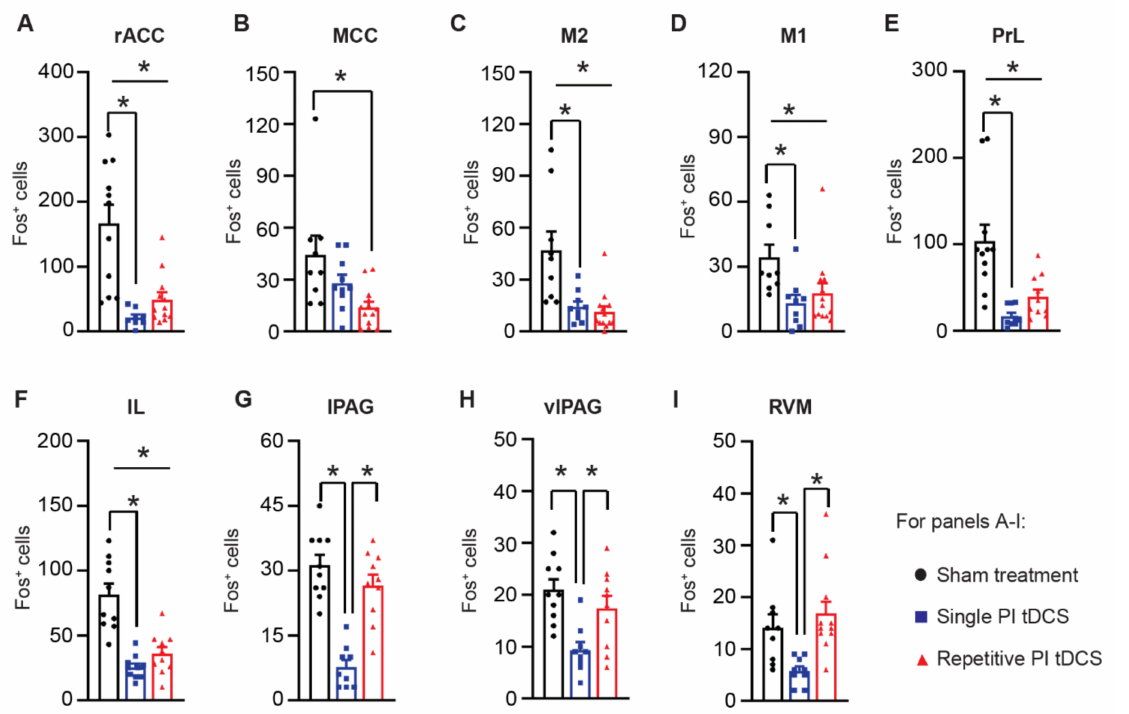
Figure 6. Immunohistochemical analysis of the surrogate marker for neuronal activity, Fos, in diverse brain regions following tDCS stimulation of PI in the form of either a single PI tDCS session or repetitive stimulation over five consecutive days compared to sham treatment. ( A – I ) Quantitative analysis of a number of Fos-expressing cells per region of interest. n = 9 sections from three mice in the sham treatment group, n = 10 sections from four mice in the single PI tDCS group, and n = 16 sections from four mice in the repetitive PI tDCS group; repeated ANOVA with Sidak’s multiple comparisons tests were performed; * p < 0.05 as compared to the corresponding control group. n.s.: non-significant. Data are represented as mean ± S.E.M. Abbreviations: rostral anterior cingulate cortex (rACC), midcingulate cortex (MCC), primary and secondary motor cortex (M1 and M2), prelimbic cortex (PrL), infralimbic cortex (IL), lateral periaqueductal grey (lPAG), ventrolateral periaqueductal grey (vlPAG), and rostral ventromedial medulla